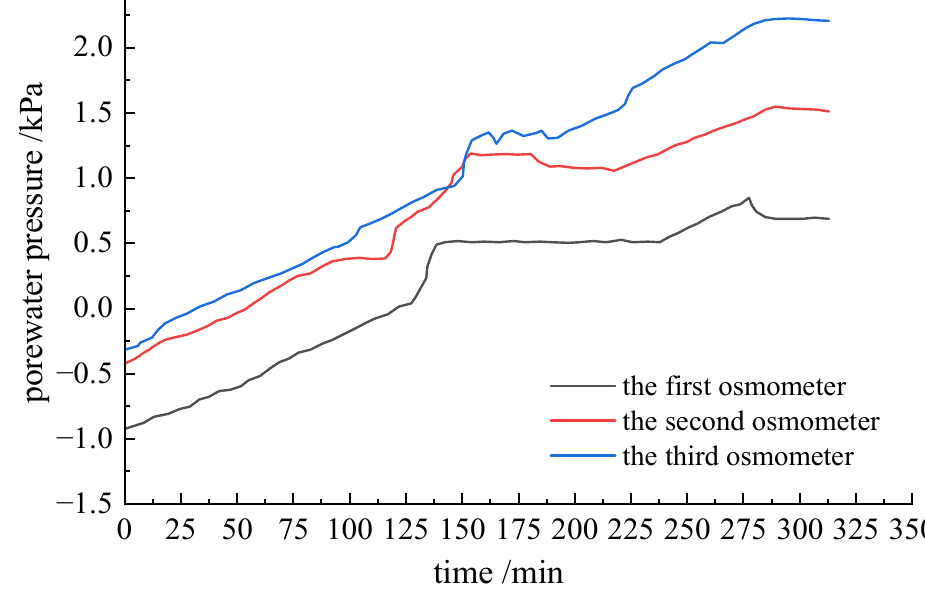
Figure 3. Change in pore water pressure in the slope under rainfall.